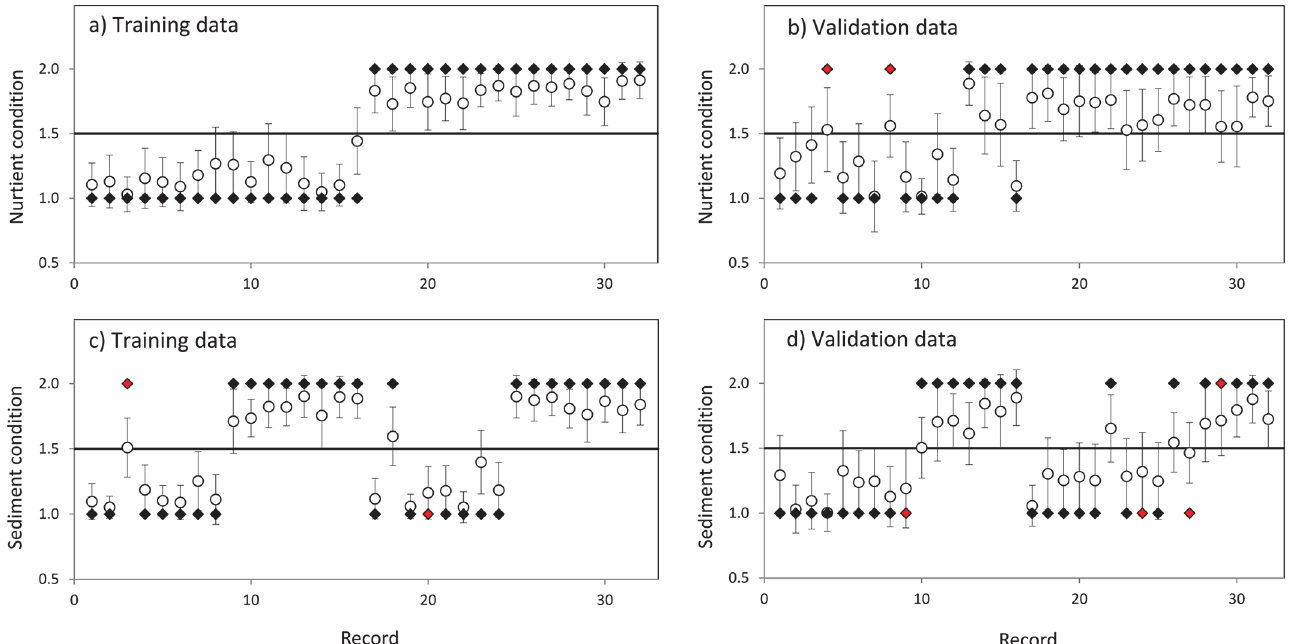
Fig 5. Validation results for ANNs trained to predict nutrient or fine sediment condition. Predictions from nutrient ANNs were generated from training (a) and validation (b) datasets. Predictions from sediment ANNs were generated from training (c) and validation (d) datasets. Each pair of points represents one mesocosm (labelled ‘ Record ’ ): the white circle is plotted at the mean (+/- standard deviation) of the condition scores predicted by 50 ANNs, while the black diamond plots the actual condition (nutrient or sediment level) of each mesocosm as 1 (low) or 2 (high). Diamonds coloured red indicate an incorrect